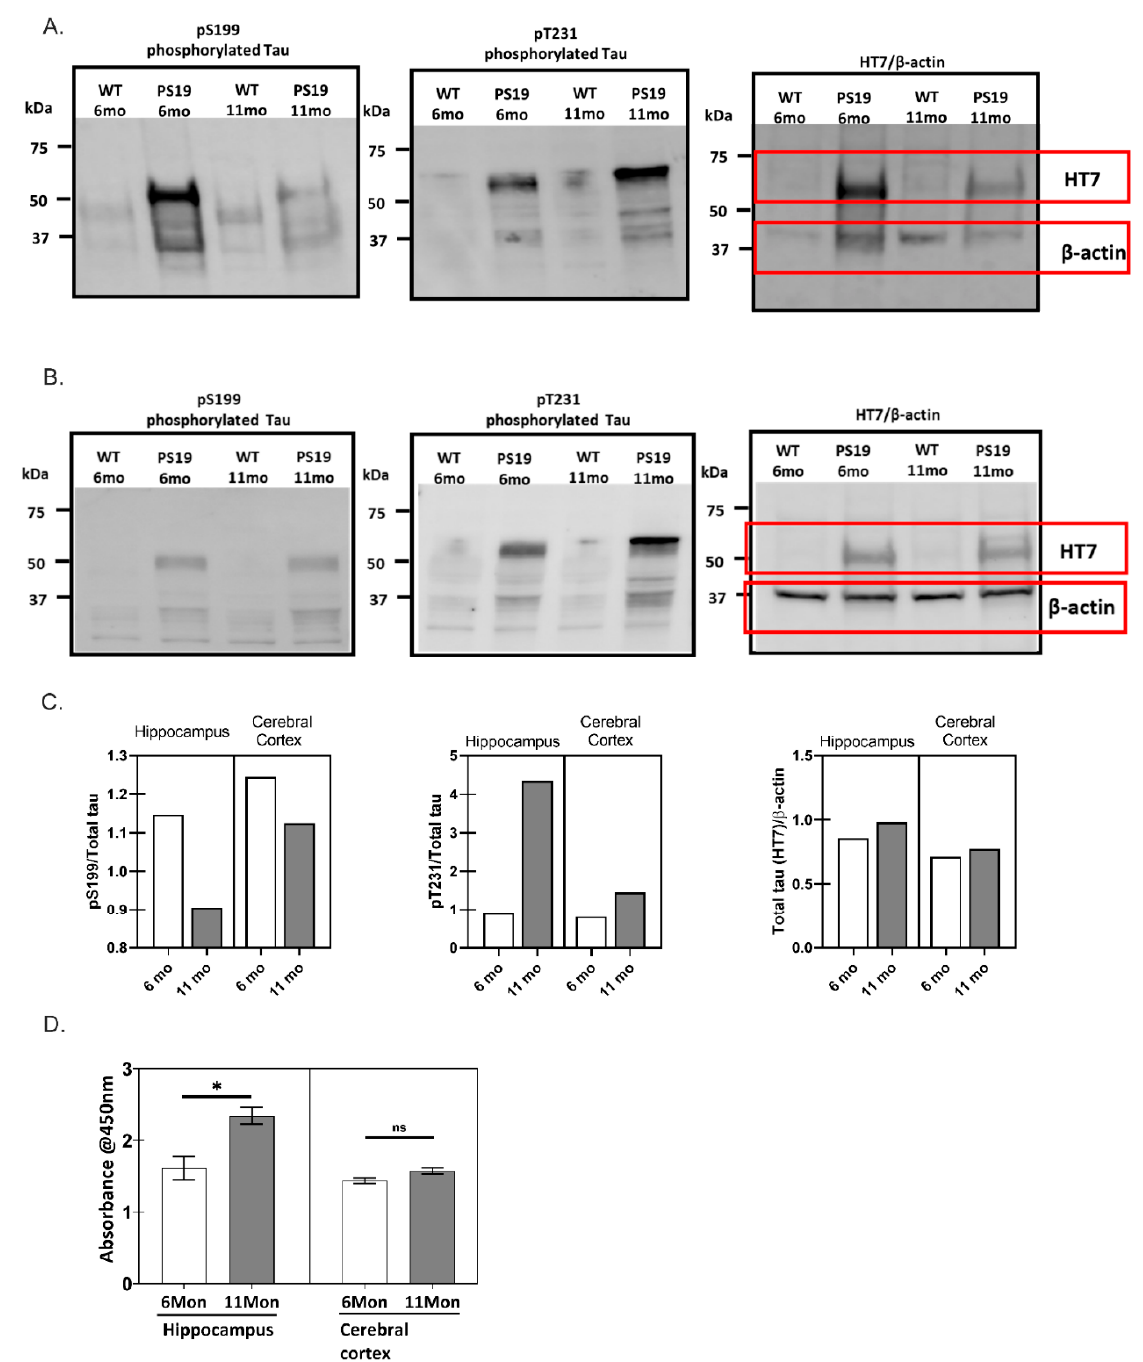
Figure 1. The phosphorylation characteristics of PS19 transgenic mice brain extracts. Immunoblot of phosphorylated tau at Ser199 (pS199), Thr231 (pT231), and total tau (HT7) detected in the crude cell lysate of 6- and 11-month-old wild type (WT) and P301S (PS19) mice hippocampus ( A ) and cerebral cortex ( B ). ( C ) Quantification of the relative ratio of tau markers, pS199 and pT231, to total tau for PS19 mice hippocampus and cerebral cortex at 6- and 11-month-old (normalized to the average level in 6-month-old PS19 mice counterpart, which was set to 1. Total tau level was normalized to an endogenous control, β -actin. ( D ) The oligomeric tau content in crude cell lysates from 6- and 11-month-old PS19 mice hippocampus and cerebral cortex was measured and quantified by ELISA assay (* represents p < 0.05 between average of different groups, n = 3; ns = not